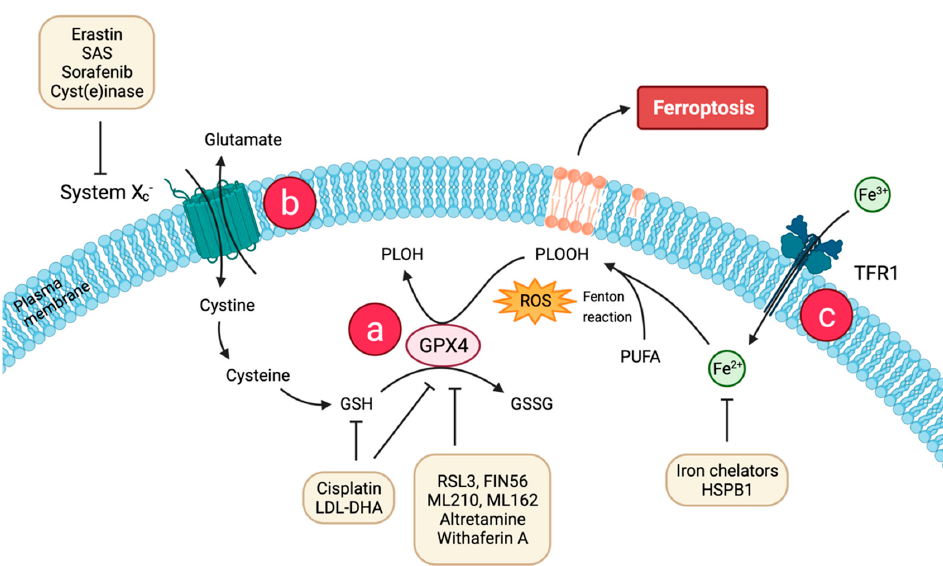
Figure 1. Molecular basis of ferroptosis and strategies for therapeutic induction of ferroptosis. A key cause of ferroptosis is the lipid radical chain reaction leading to excessive production and failure of elimination of phospholipid hydroperoxides (PLOOH). Two major mechanisms mediated by ( a ) glutathione peroxidase 4 (GPX4) and ( b ) system x c − serve to prevent PLOOH accumulation. System x c − mediates the uptake of cystine for the production of cysteine and glutathione (GSH). GPX4 converts GSH to glutathione disulfide (GSSG), resulting in reduced PLOOH and inhibition of ferroptosis. ( c ) Extracellular Fe 3+ enters the cell through transferrin receptor 1 (TFR1) on the cell membrane, is reduced to Fe 2+ , and is combined with reactive oxygen species (ROS) to participate in lethal iron-dependent peroxidation of polyunsaturated fatty acids (PUFAs), and finally induces ferroptosis. Multiple ferroptosis-inducing agents (system x c- , GPX4 inhibitors, nanoparticles) hold great promise for cancer therapy. Created with BioRender. Available online: https://biorender.com